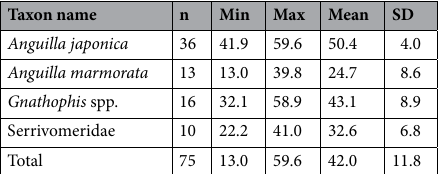
Table 1. Total length of leptocephalus in four taxa. s.d. indicates standard